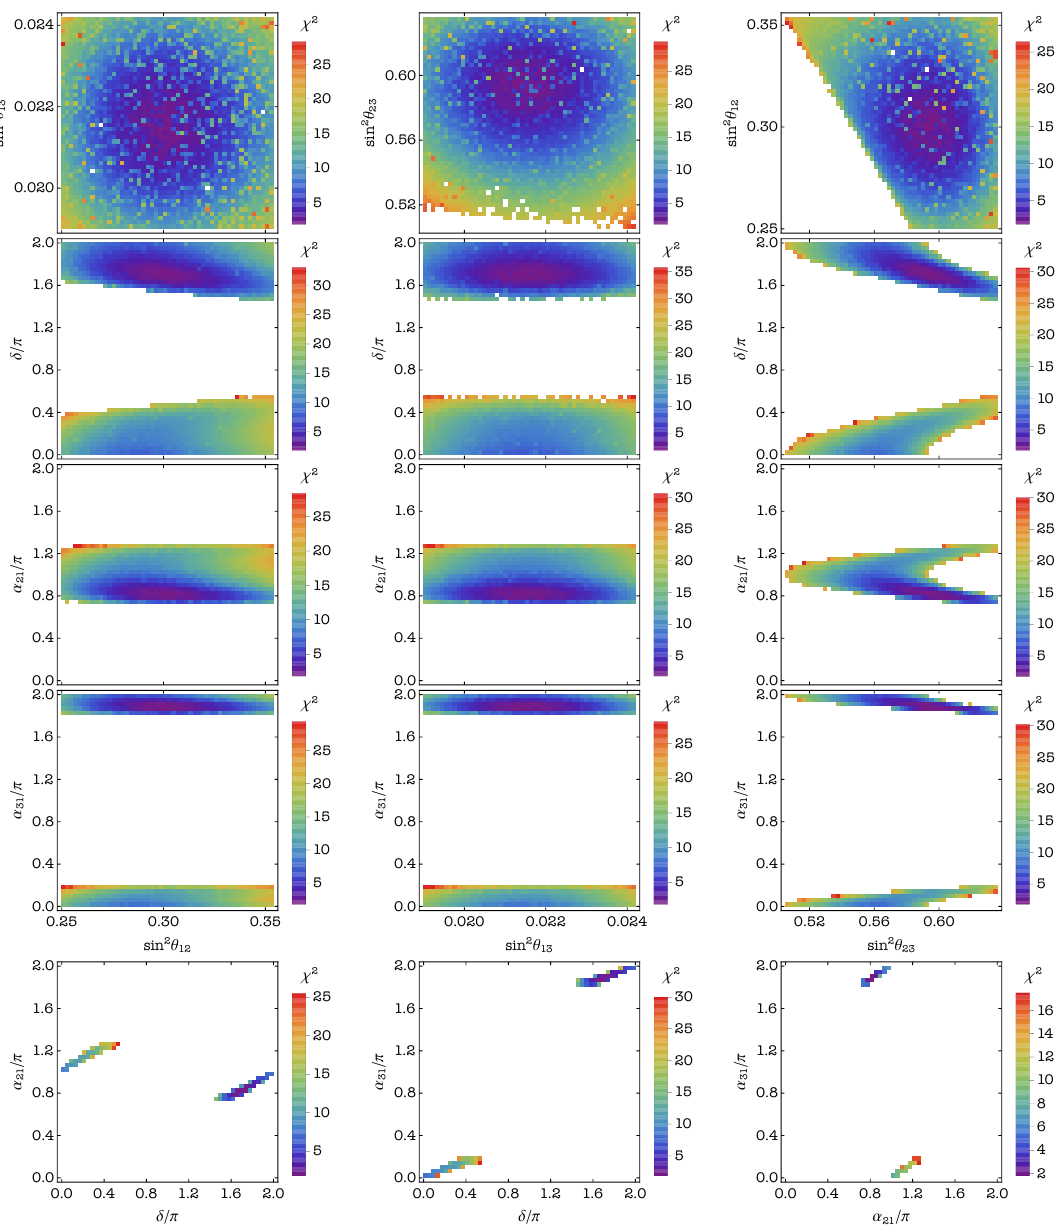
Figure 8 . Correlations between the neutrino mixing parameters in case C4. The values of all the three mixing angles are required to lie in their respective 3 (cid:27) ranges. Colour represents values of (cid:31) 2 for the IO neutrino mass spectrum.